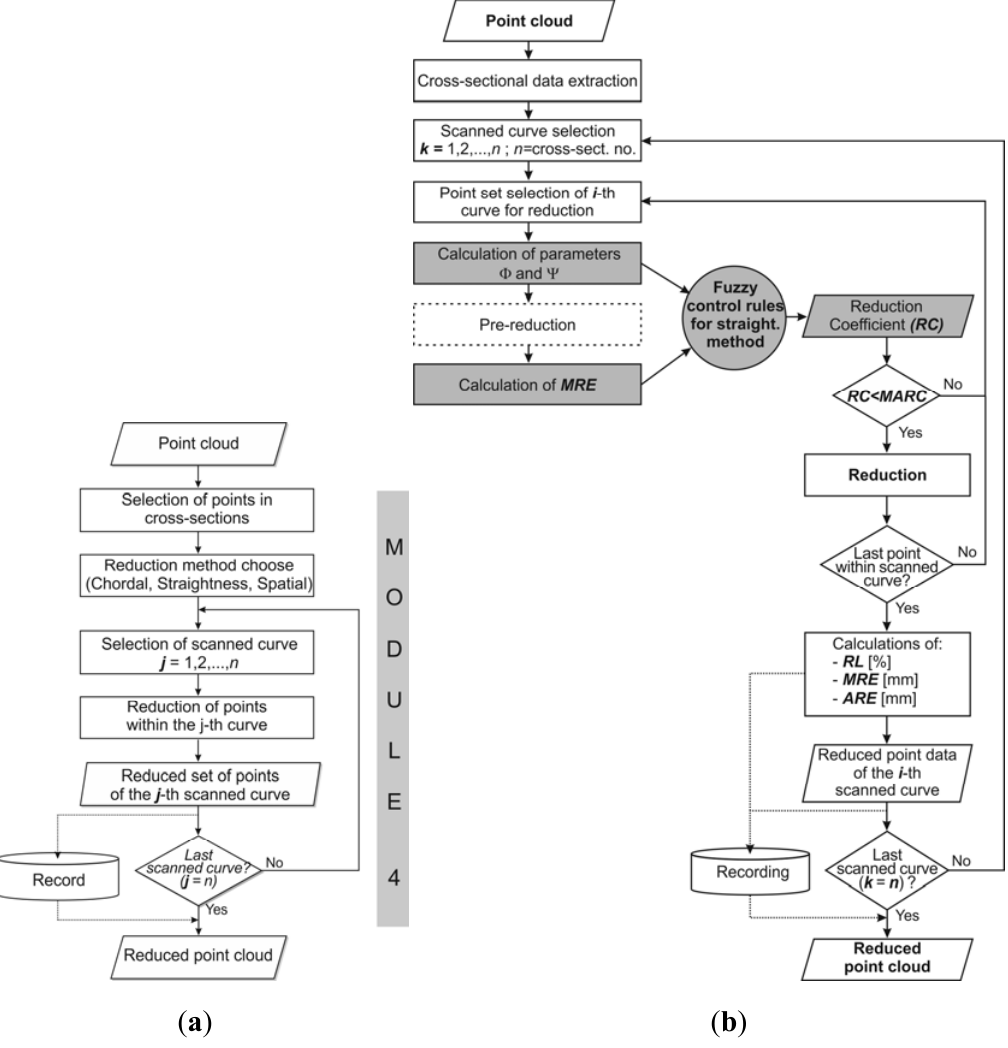
Figure 6. ( a ) Algorithm of the developed module for point data reduction based on